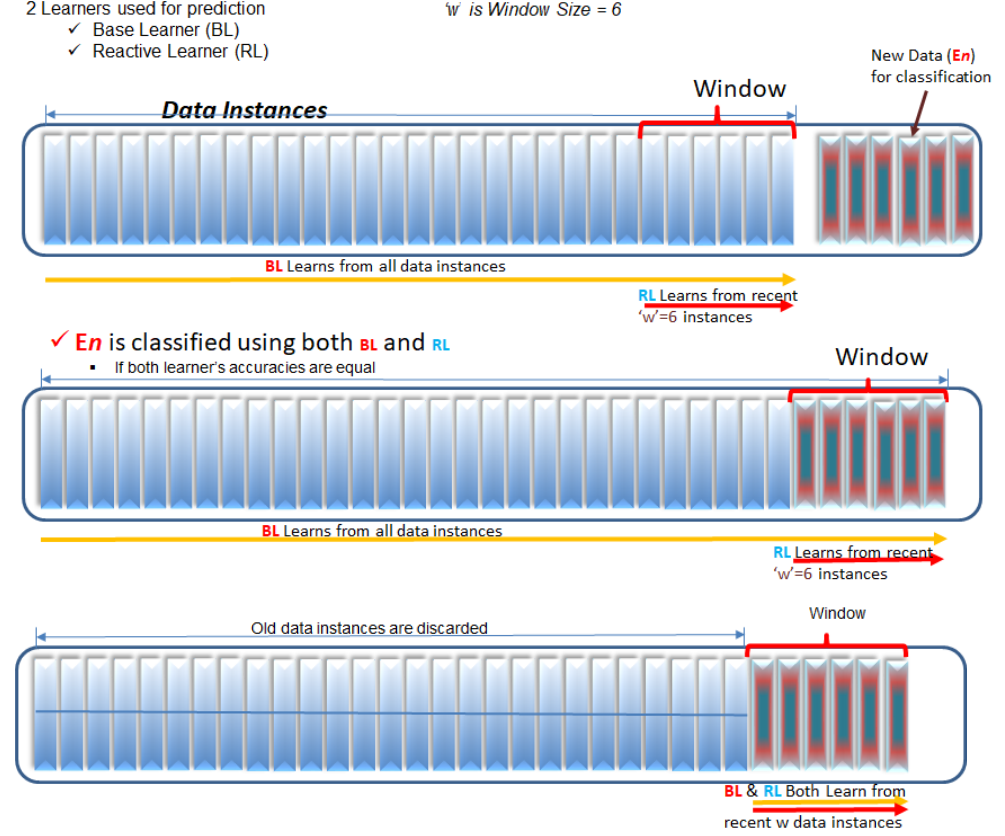
Figure 1. Concept of the proposed approach based on